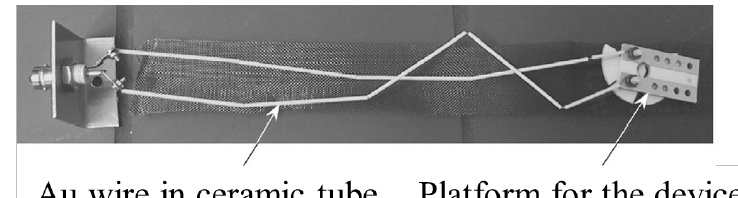
Figure 6. The surface acoustic wave device for high-temperature tests [65] (copyright 2006 by the IEEE).